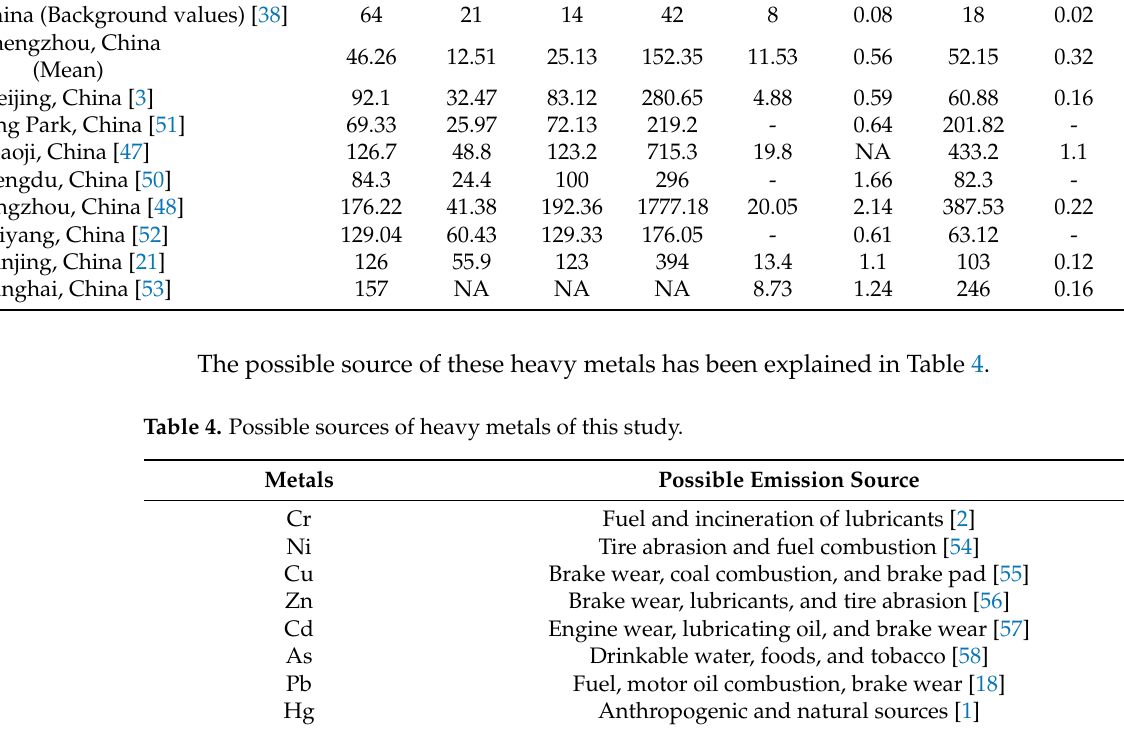
Table 3. Comparison of concentrations with other cities of China in (mg/kg). City